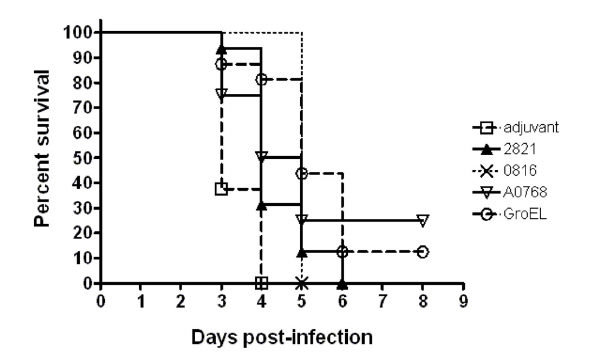
FIGURE 3 | Evaluation of a subset of the vaccine candidates identified by ELI, tested individually. Groups of 12 BALB/c mice were i.p. injected with the five candidates and GroEL (BMA 2001) delivered as recombinant bacterially produced proteins.These were formulated with ISCOMs and CpG’s as adjuvants (adjuvant). Boosts were administered at week 4 post-prime and challenged by i.n. route with 2 LD 50 (1 × 10 5 ) B. mallei ATCC23344 at week 7. Survival was monitored, recorded and analyzed as described in the Section “Materials and Methods.”The Mantel–Haenszel survival curves for the control groups and for the three test groups that displayed statistically significant protection ( p < 0.05) are plotted. GenBank BMA gene numbers are